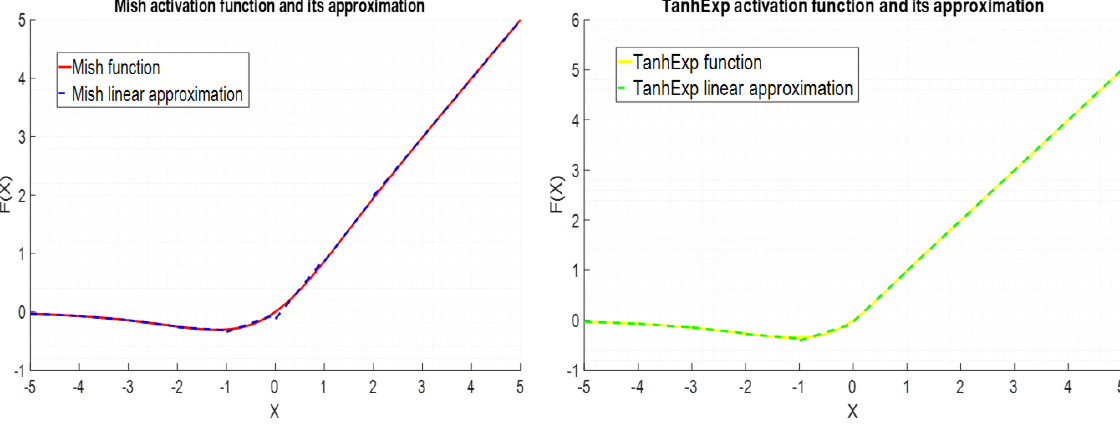
Figure 10. Activation functions and their